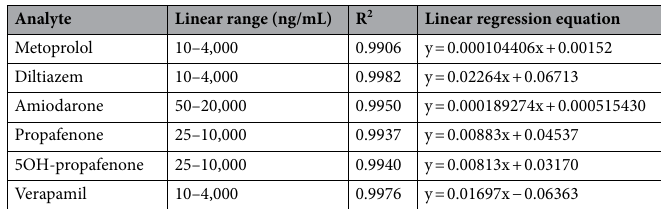
Table 3. Linear range, coefficient of correlation (R 2 ), and linear regression